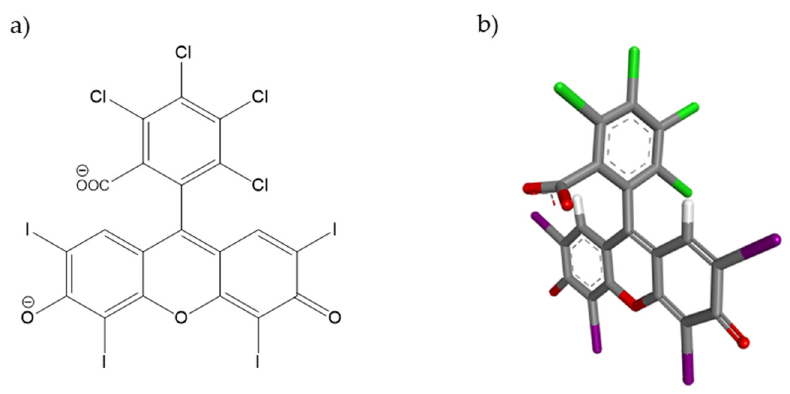
Figure 1. Chemical structure of Rose Bengal. ( a ) Structure 2D. ( b ) Structure 3D.